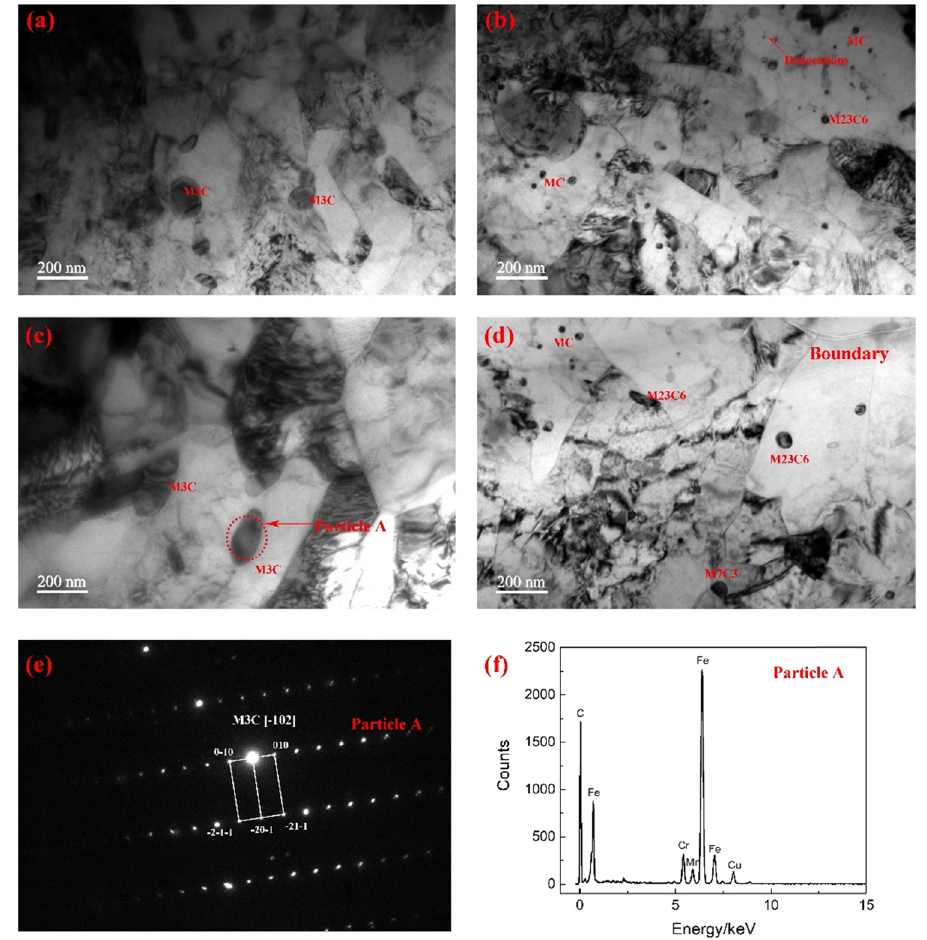
Figure 9: The tempered microstructure of the two steels by TEM at 650°C for di ff erent tempering times: ( a ) 2 h - 5CrNiMoV, (